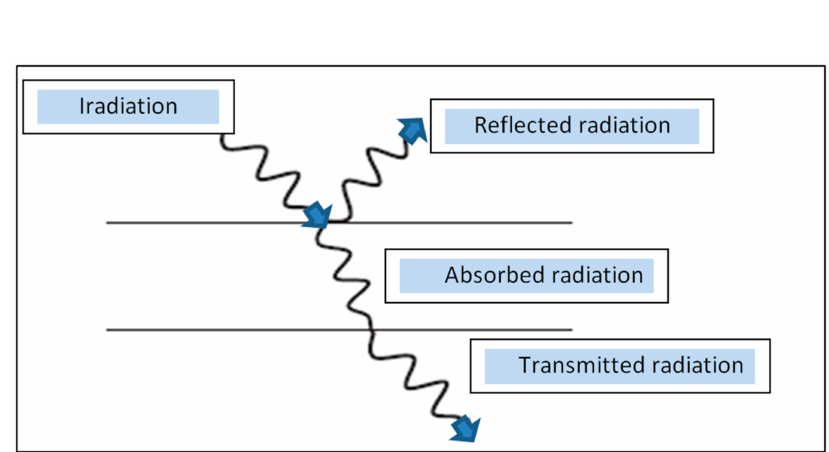
Figure 3. Extinction of radiation